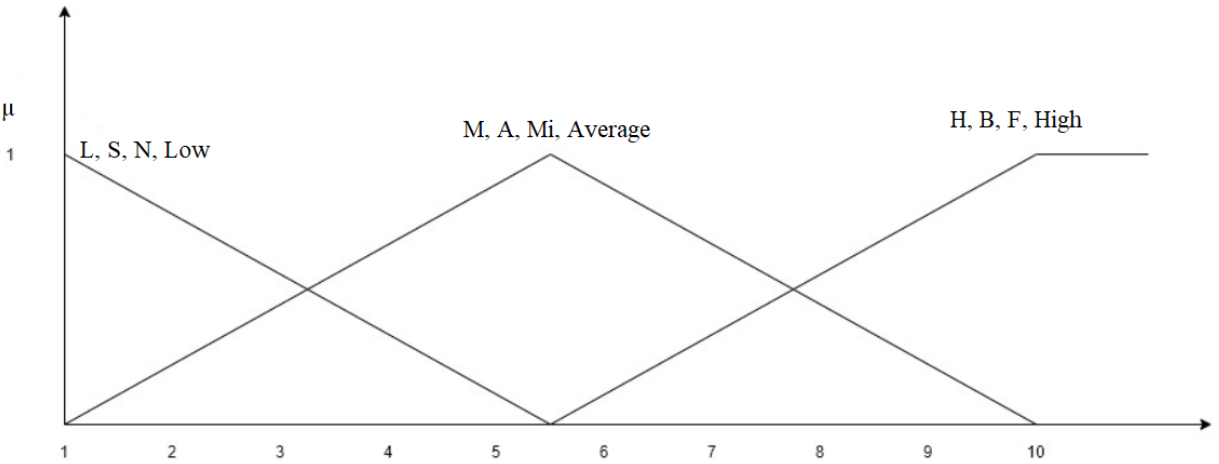
Figure 4. Fuzzy triangular membership functions for INRE, INFBS, and INDE, and their relative importance.